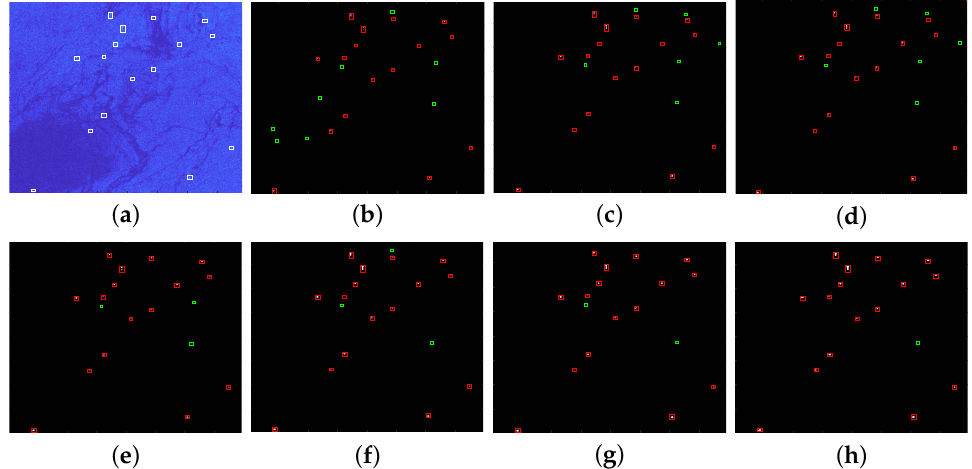
Figure 9. Detection results of different methods for scene 3. ( a ) original image; ( b ) CA-CFAR method; ( c ) G Γ D-CFAR method; ( d ) new LN-2PCFAR method; ( e ) MVWIE method; ( f ) FMPCM method; ( g ) IG method; ( h ) proposed